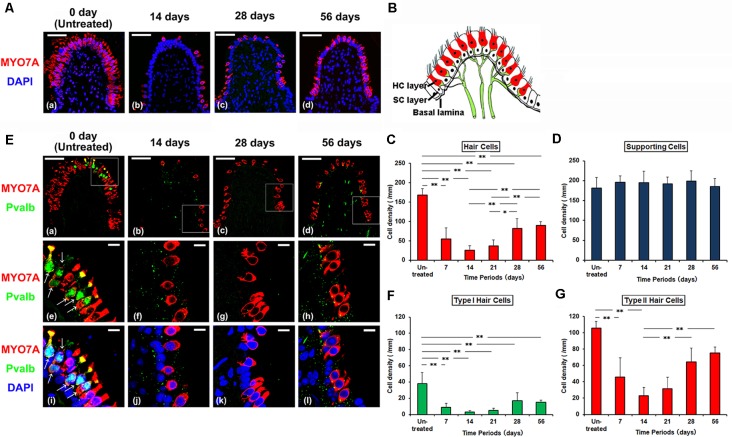
(A) Histologic changes of supporting cells (SCs) and hair cells (HCs) of the crista ampullaris from untreated control (a), 14 days (b), and 28 days (c) and 56 days (d) after gentamicin (GM) treated. Red represents anti-Myosin7a (MYO7A) labeling HCs and blue represents DAPI labeling of ds-DNA in the nuclei of cells. Scale bar = 50 μm. (B) The schema of crista ampullaris. (C) The densities (Mean ± SD) of HCs were reduced at 7 and 14 days post GM treatment (PT), followed by an increase at 28 and 56 days PT. (D) The cell densities (Mean ± SD) of SCs in all the observation periods did not change. (E) Histologic changes of type I HCs and type II HCs from untreated control (a), 14 days (b), 28 days (c) and 56 days (d) after GM treated. Each middle (e–h) and bottom (i–l) panel magnifies the boxed area in the respective top panel (a–d). Red represents anti-MYO7A labeling HCs, green represents anti-Parvalbumin (Pvalb) labeling nerve calyces of type I HCs (arrow), and blue represents DAPI labeling of ds-DNA in the nuclei of cells. Scale bar = 50 μm (a–d). Scale bar = 10 μm (e–l). (F) The densities (Mean ± SD) of type I HCs significantly reduced from 7 days PT to 56 days PT as compared with untreated control. (G) The densities (Mean ± SD) of type II HCs were reduced at 7 and 14 days PT, followed by an increase at 28 and 56 days PT. **p < 0.01, *p < 0.05.